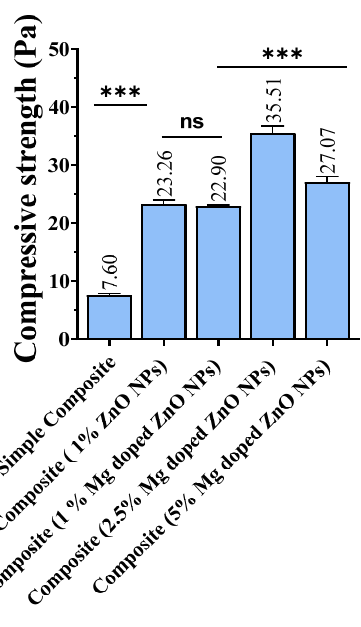
Figure 5. Compressive strength of composites with bare and Mg-doped ZnO NPs at varying con- centrations. p -value < 0.001 is flagged with three stars (***), while ns (not significant) represents statistically insignificance.